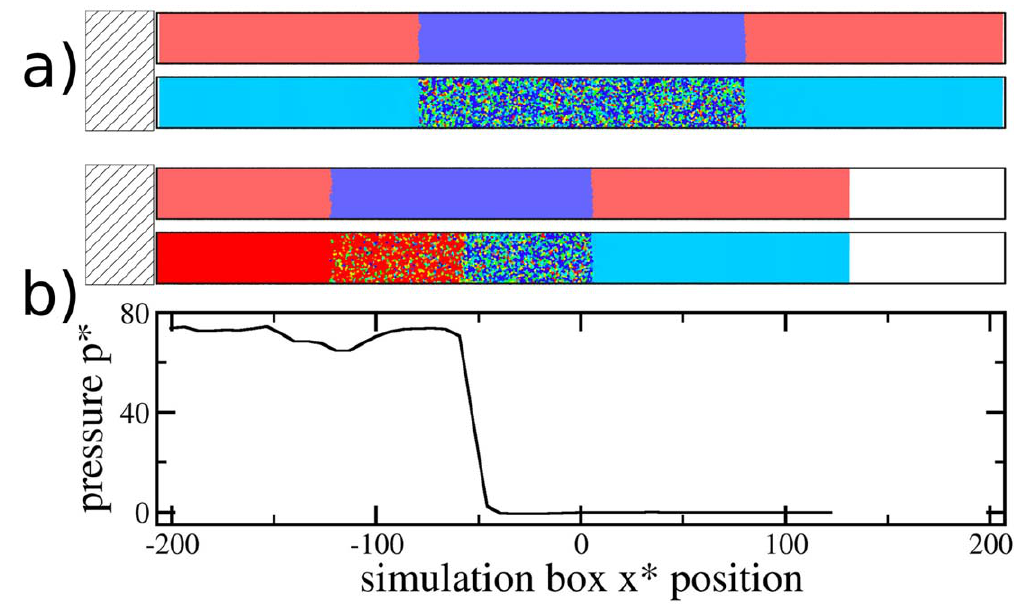
~ 6 . The snapshot is shown in two p